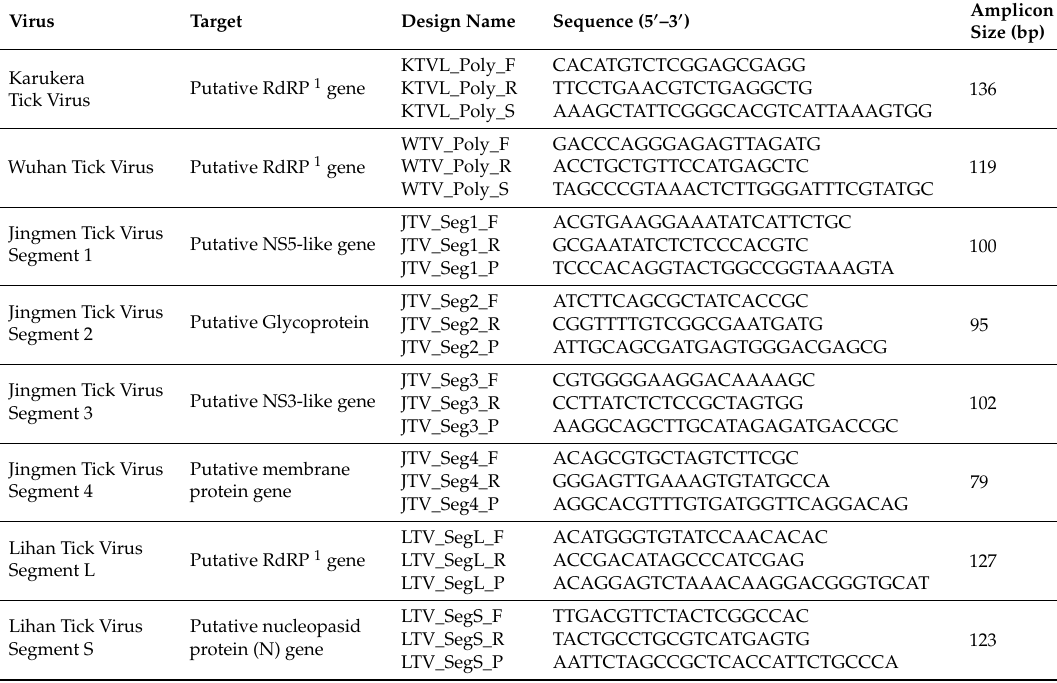
Table 1. List of the design developed in this study allowing the detection of the four RNA virus analyzed. Virus Target Design Name Sequence (5 (cid:48) –3 (cid:48)